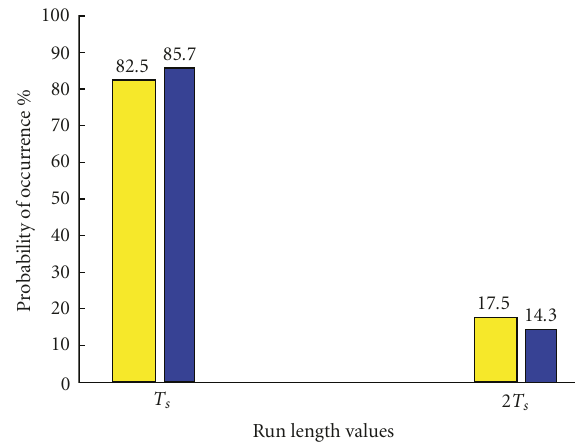
Figure 6: Histogram of the run lengths of a BOC(10,5) signal of duration 7 μ s (corresponding to 36 code chips). The lighter bars account for the computed experimental probabilities, whereas the darker bars make up for the theoretical probabilities.